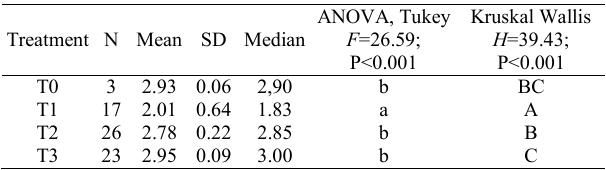
Table 3. Mean and median histological condition index (HCI) and standard deviation (SD) for Pagrus pagrus larvae from the feeding treatments. Different lowercase letters indicate significant differences (p<0.001) among feeding treatments, after one way ANOVA followed by post-hoc Tukey’s test and different capital letters indicate significant differences after Kruskal-Wallis test followed by multiple comparisons. T0: before the experiment begins, T1: without food, T2: delayed feeding and T3: fed.